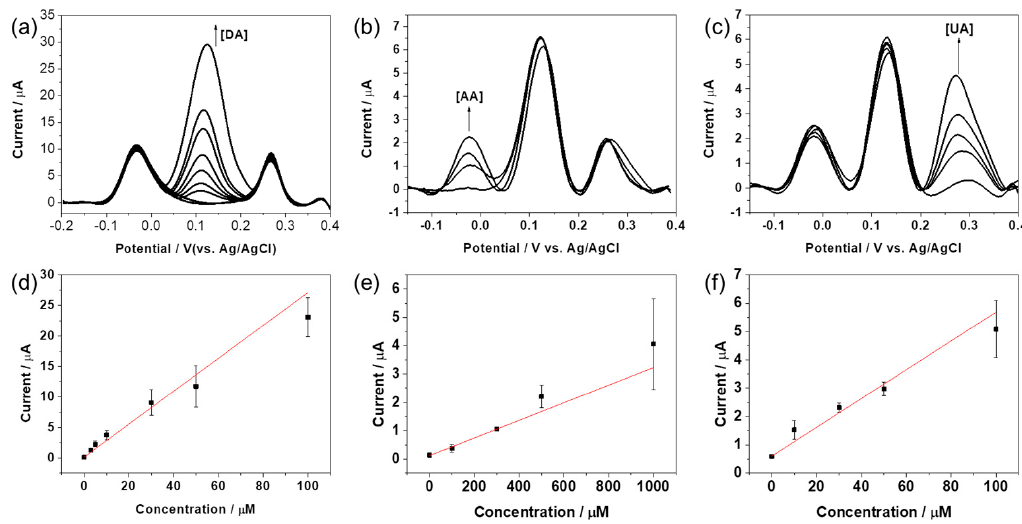
Figure 7. DPV curves of RGO/AuNPs-GCE in 0.1 M PBS (pH 7.4) mixed solution containing ( a ) 1 mM AA, 100 µ M UA, and DA in different concentrations (0, 1, 3, 5, 10, 30, 50, 100 µ M); ( b ) 100 µ M DA, 100 µ M UA, and AA in different concentrations (0, 100, 300, 500, 1000 µ M); and ( c ) 1 mM AA, 100 µ M DA, and UA in different concentrations (0, 10, 30, 50, 100 µ M). Calibration curves of ( d ) DA, ( e ) AA, and ( f ) UA.